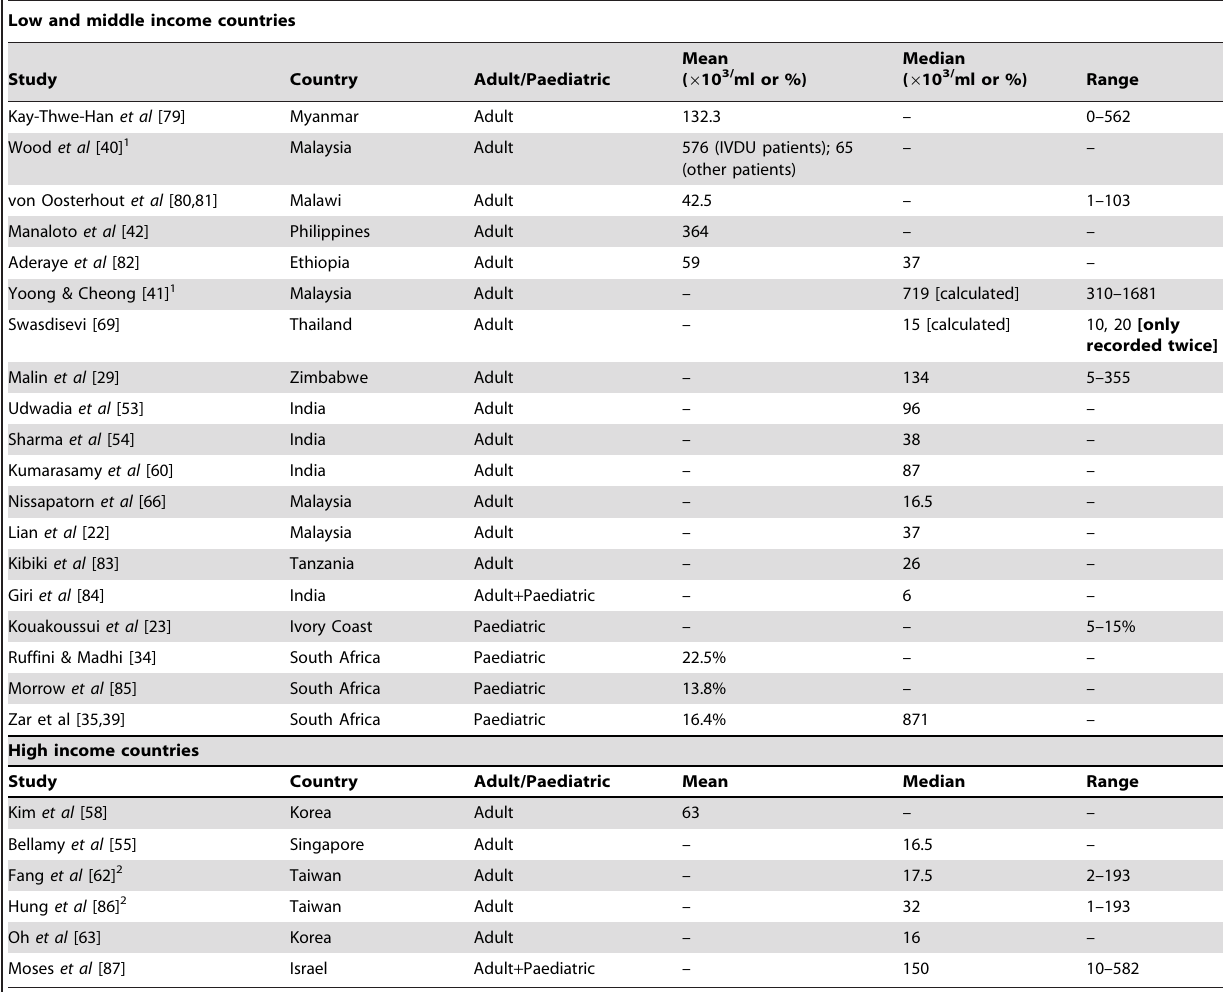
Table 9. CD4 count at presentation with Pneumocystis jirovecii pneumonia in HIV-infected